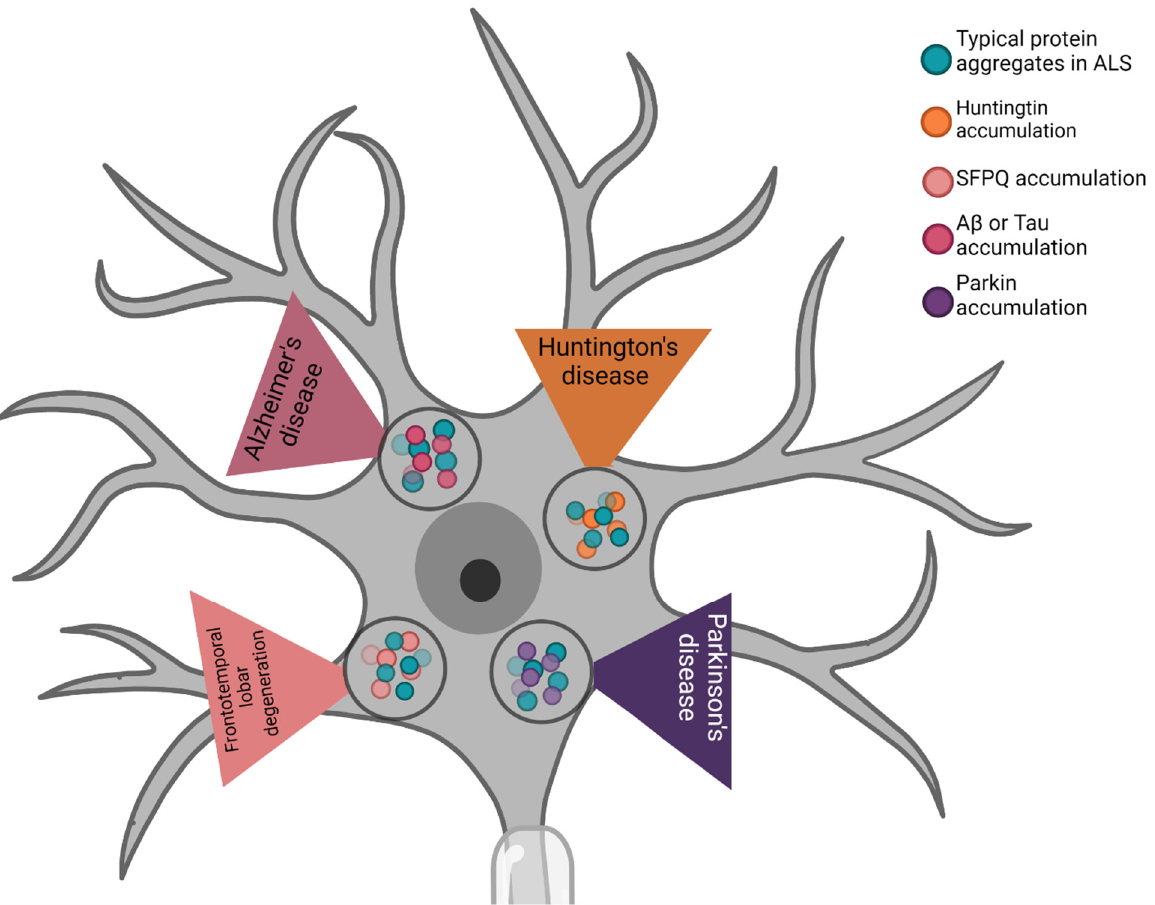
Figure 3. The protein aggregates typically associated with ALS are linked to protein inclusions in other neurodegenerative diseases, also promoting neuronal death in these pathologies .